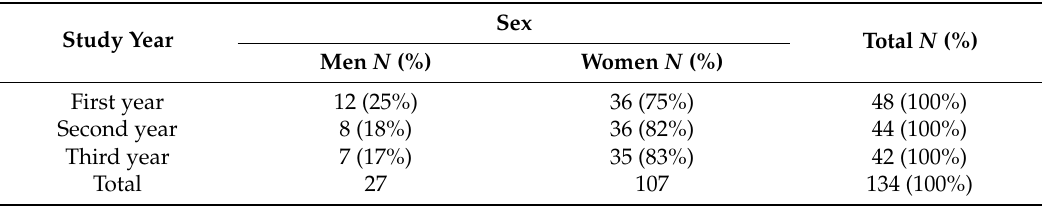
Table 1. Student